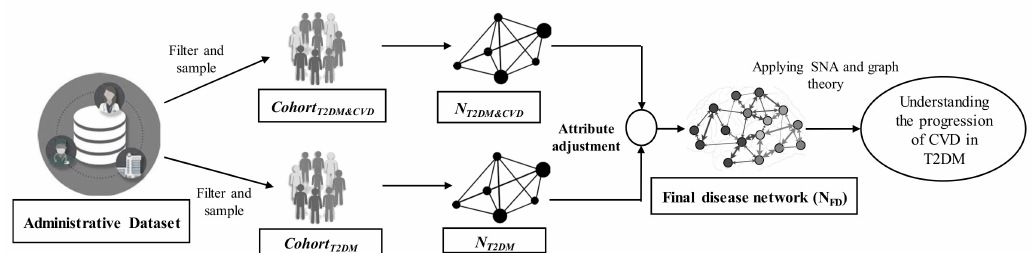
Figure 2. Proposed framework to understand the progression of cardiovascular disease in patients with type 2 diabetes. SNA: social network